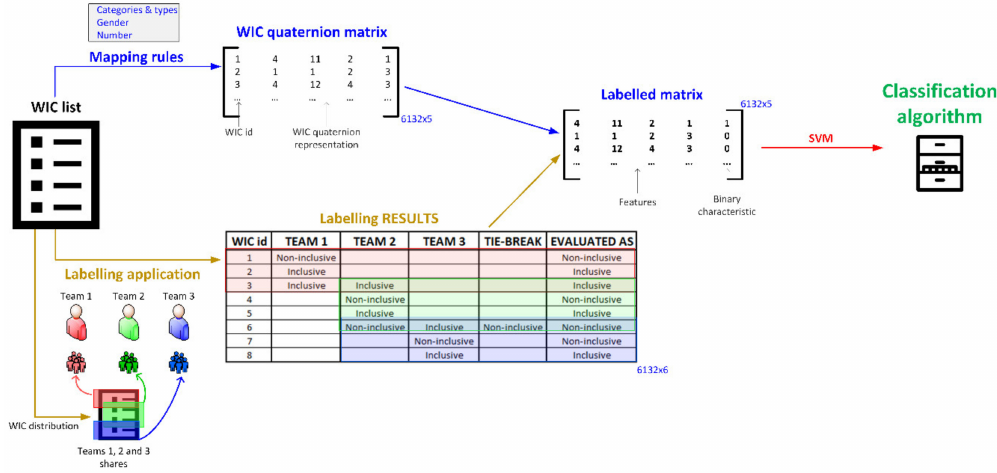
Figure 10. Sample labelling, that leads to the generation of the classification